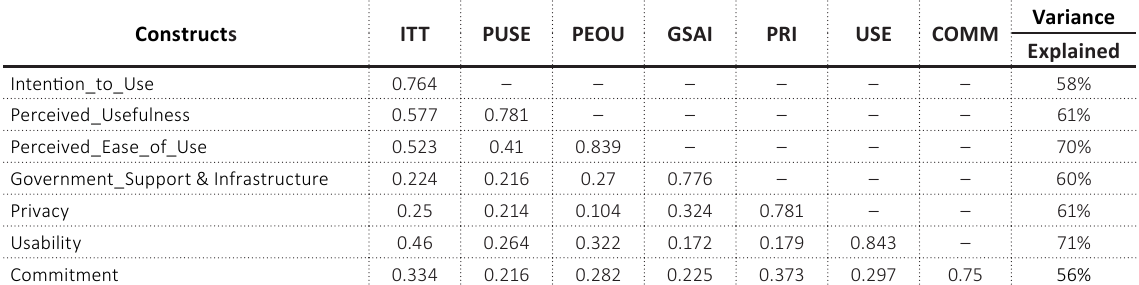
Table 6. Discriminant validity